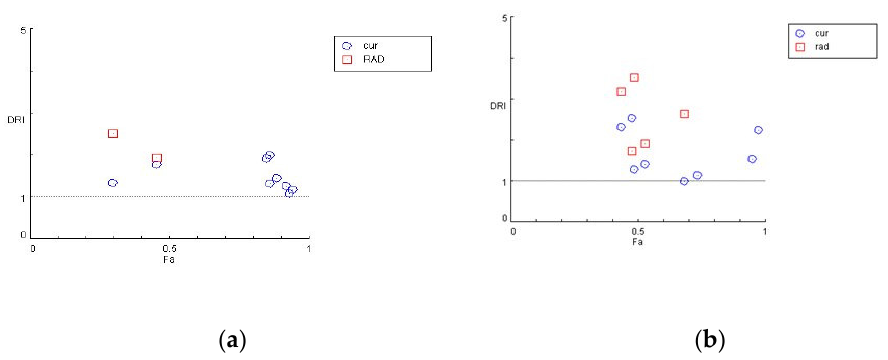
Figure 6. Dose reduction plots for the combination of curcumin and radiation at different experi- mental points for U87 ( a ) and T98 ( b ) cells. DRI >1 shows favorable dose reduction of both factors.